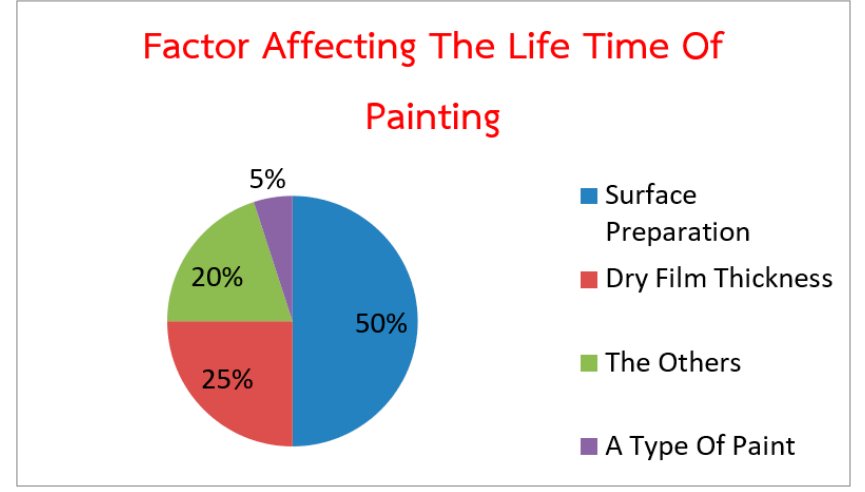
Figure 1. Factor affecting the life time of painting or coating.